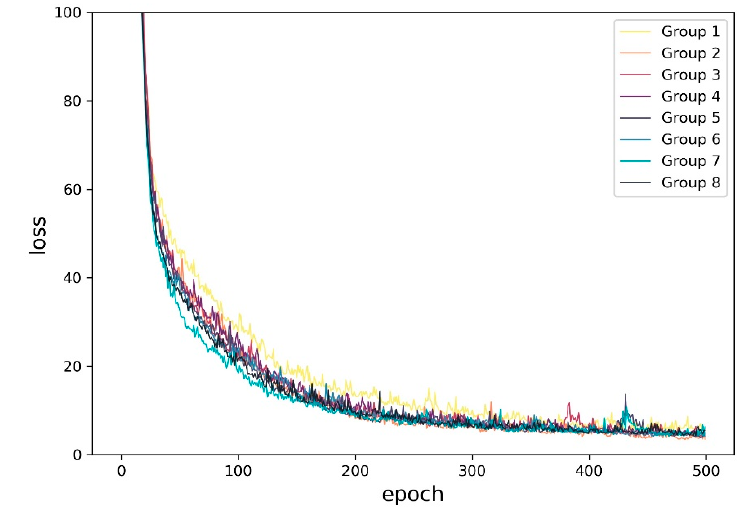
Figure 15. Predicted population density loss versus epoch number for the eight groups.